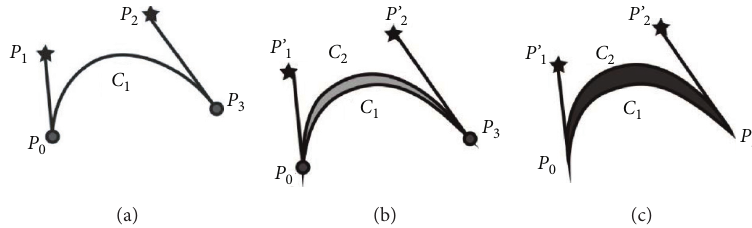
Figure 11: Brush style line making. (a) Inner borders. (b) Outer borders. (c) Filling.